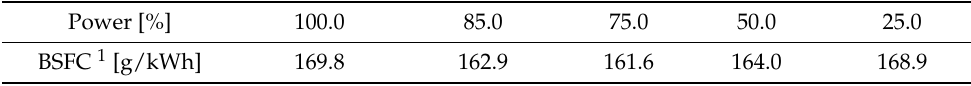
Table 4. BSFC data of the DE WinGD X62-B (Data from: [36]).